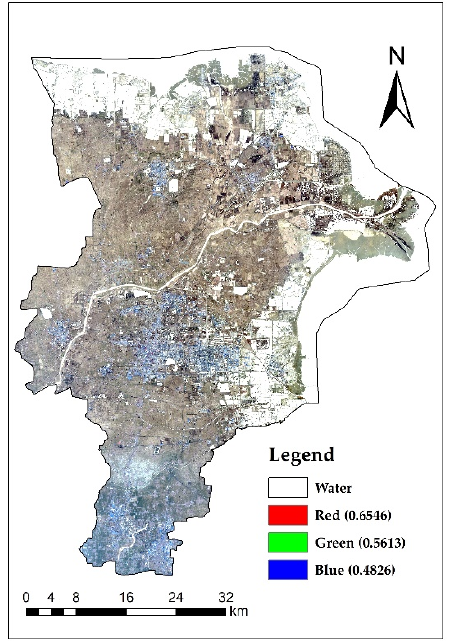
Figure 4. Dongying true color image after water masking with MNDWI. Within the boundary of Dongying vector, the white area is water, which has the same value as the background, and the non-water area is stretched according to the red, green, and blue band.